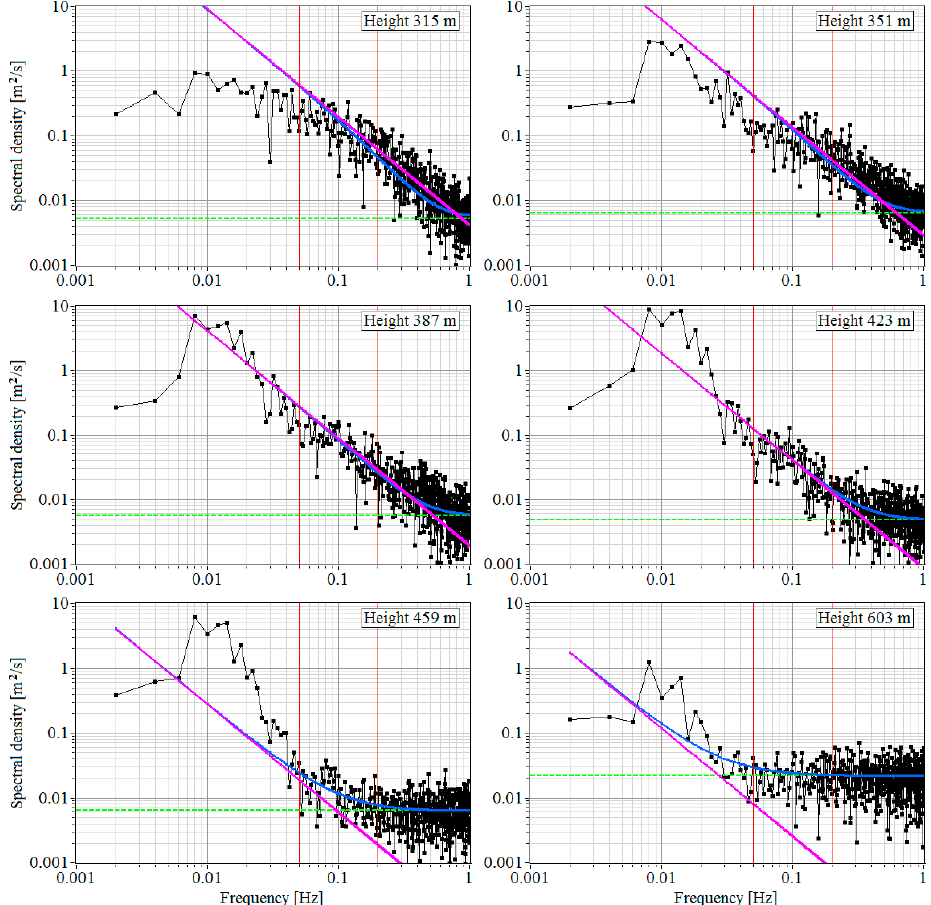
Figure 10. Experimental spectral densities of vertical velocity (black curves) and noise component S N (green dashed lines) at different heights as calculated from data of the 2D distribution in Figure 9. Measurements from 03:02 to 03:33 LT on 2 July 2020. Blue and pink curves are for the results of calculation of, respectively S L ( f l ) and S K ( f l )